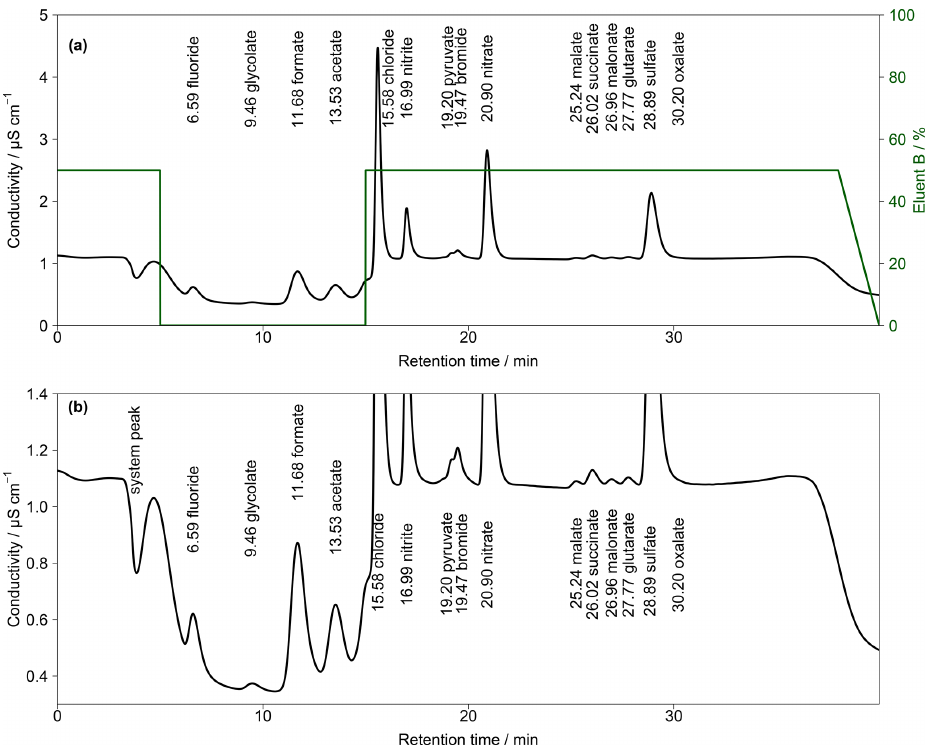
Figure 4. (a) Chromatogram of an aqueous standard solution with concentrations of 10µgL − 1 for Cl − , NO − NO − ; and 1µgL − 1 for F − , Br − and all organic acids with the gradient system. Numbers in front of the ion names indicate the retention 2 times in minutes. The fraction of eluent B within the eluent mixture over time is given as the green line. The eluent concentration of A is 0.5mM Na 2 CO 3 / 0.75mM NaOH and of B is 20mM Na 2 CO 3 / 0.75mM NaOH. T = 65 ◦ C and eluent flow is 0.8mLmin − 1 . (b) Zoom in of (a)